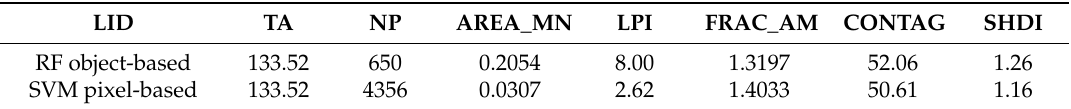
Table 6. The comparison of landscape pattern metrics of random forest (RF) object-based and support vector machine (SVM) pixel-based classifications at landscape